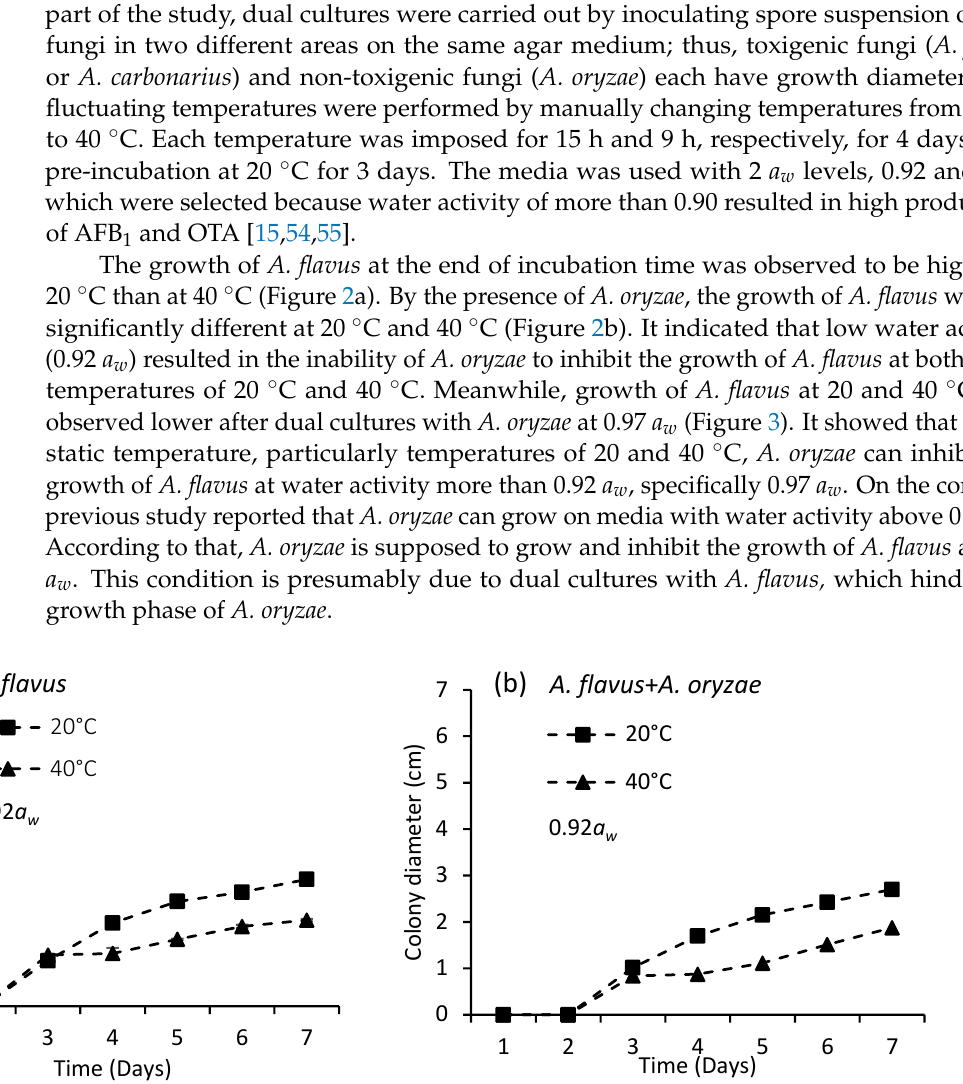
Figure 3. Growth of A. flavus in ( a ) single and ( b ) dual cultures with A. oryzae incubated under static temperatures of 20 °C and 40 °C for 7 days at 0.97 a w on chili-based agar. In A. carbonarius, no growth was observed at static temperatures of 40 °C, at 0.97 a w and 0.92 a w . At 20 °C and 0.92 a w , there were no significant differences observed between the growth of A. carbonarius in single and dual cultures with A. oryzae (Figure 4a). By increasing the water activity to 0.97 a w , A. carbonarius in single and dual cultures was also increasing at the same temperature. Under such condition, A. carbonarius in single culture was observed to be higher than in dual culture (Figure 4b). It indicated that A. oryzae would be adequate to inhibit the growth of A. carbonarius at a high water activity (0.97 a w ).